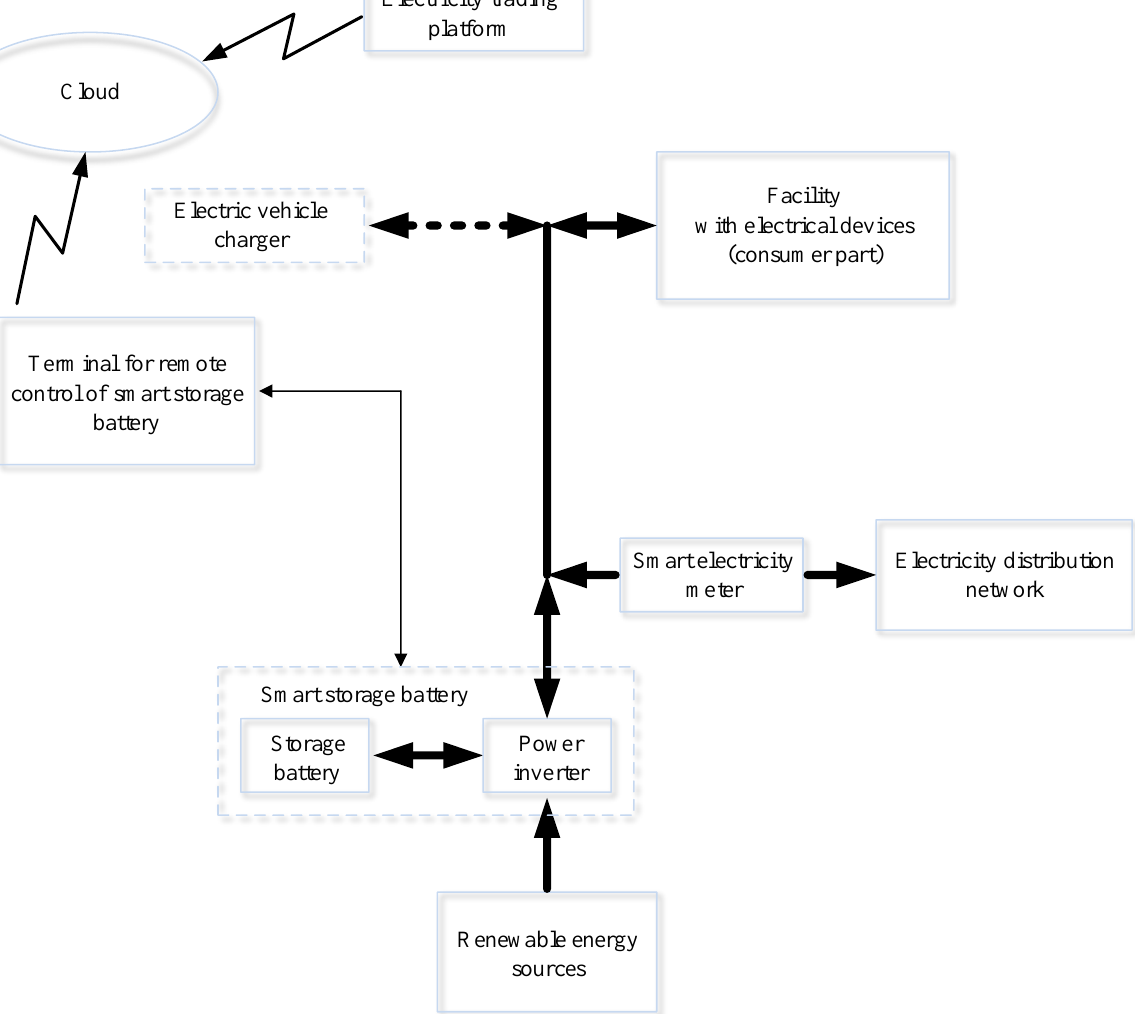
Figure 3. The subsystem for remote control of smart batteries. Considering that there are batteries in the electric vehicles themselves, the use of those batteries (V2G concept) in vehicles has recently been considered a great deal. Since that concept depends significantly on the availability of the vehicles, in this work, a special independent battery—smart battery—is provided for the sake of reliability. However, certainly, a detailed analysis of whether and in which case vehicle batteries would be sufficient can be the subject of further